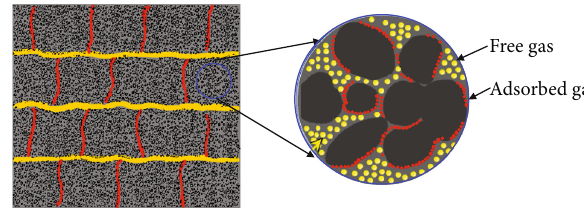
Figure 2: The adsorbed gas and free gas in coalbed